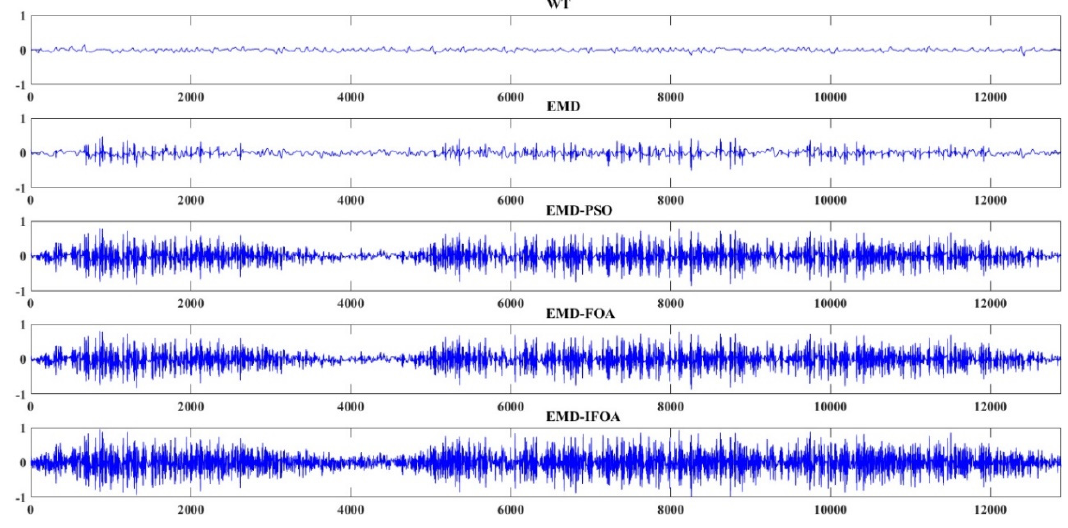
Figure 7. The denoised signal of the five noise elimination schemes. PSO: particle swarm optimization algorithm; WT: wavelet transform; FOA: fruit fly optimization algorithm.